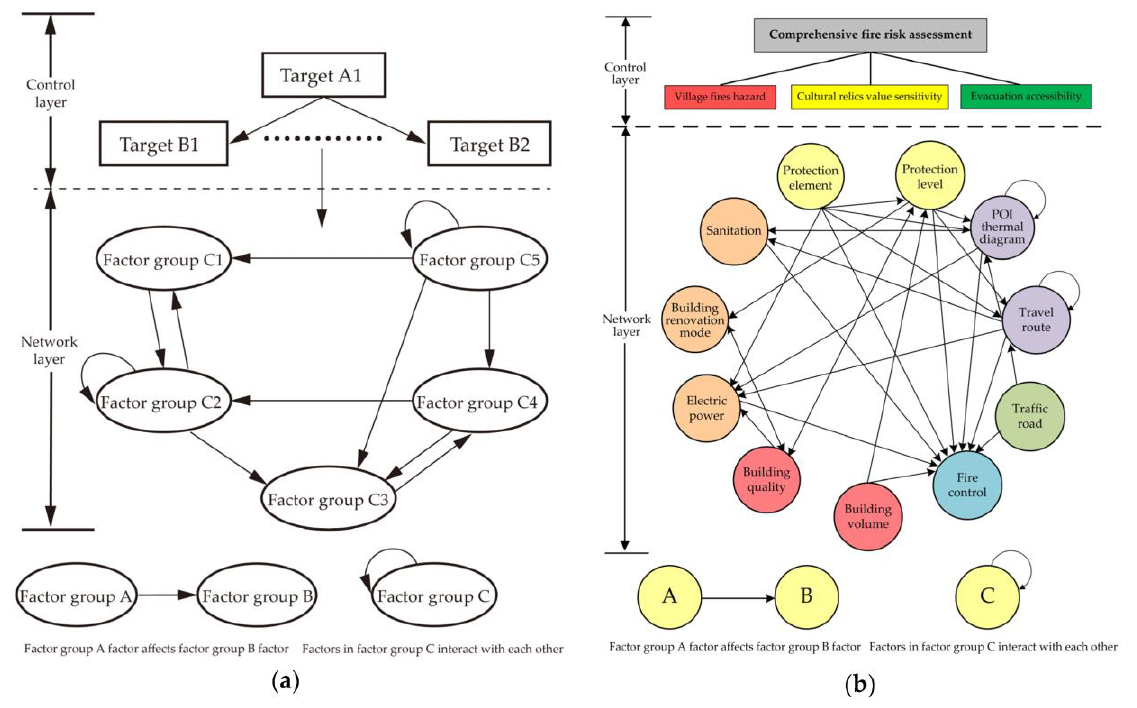
Figure 8. ( a ) Typical ANP network structure; ( b ) ANP fire risk assessment index network.